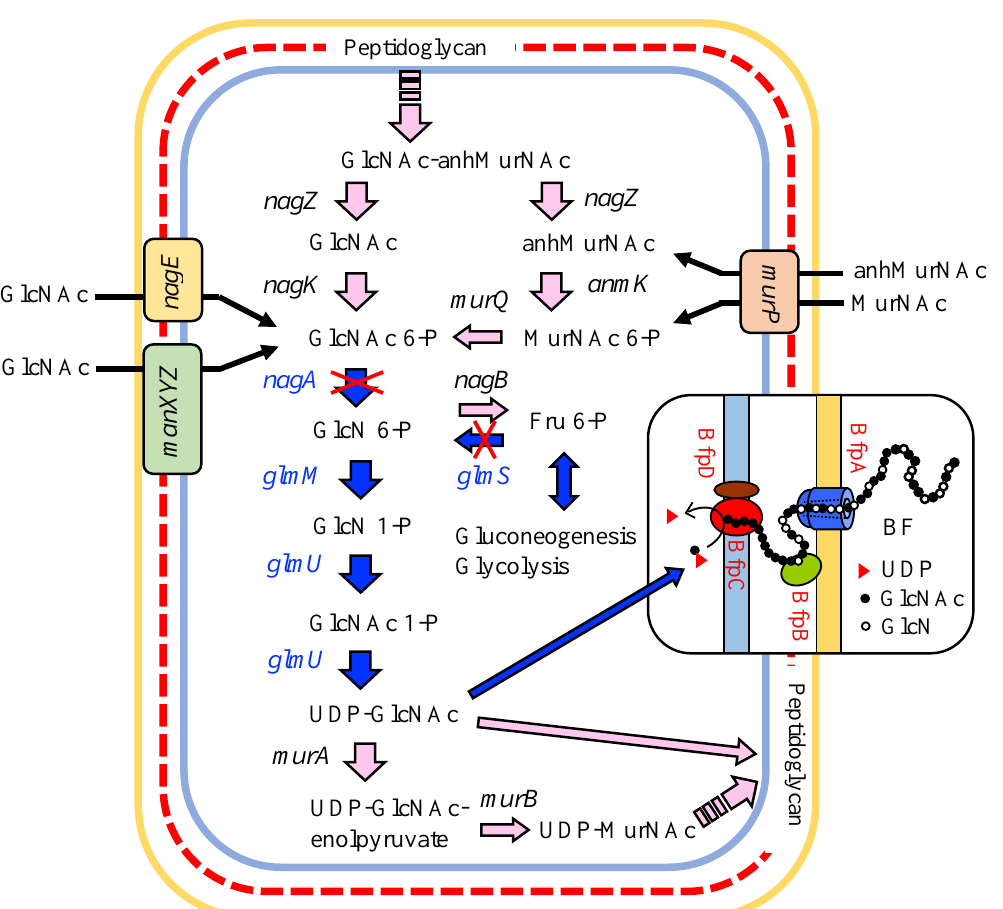
Figure 6. Amino sugar metabolism, peptidoglycan synthesis and recycling, and the putative polymerization and secretion mechanisms involved in production of the chitin/chitosan-like bioflocculant. These pathways and mechanisms are depicted based on information obtained from published reports [13,21–23]. Blue arrows and gene names indicate the proposed BF synthetic pathway and genes, respectively. Abbreviations: BF, bioflocculant; GlcN, glucosamine; GlcNAc, N -acetylglucosamine; MurNAc, N -acetylmuramic acid; P, phosphate; anh, anhydro.